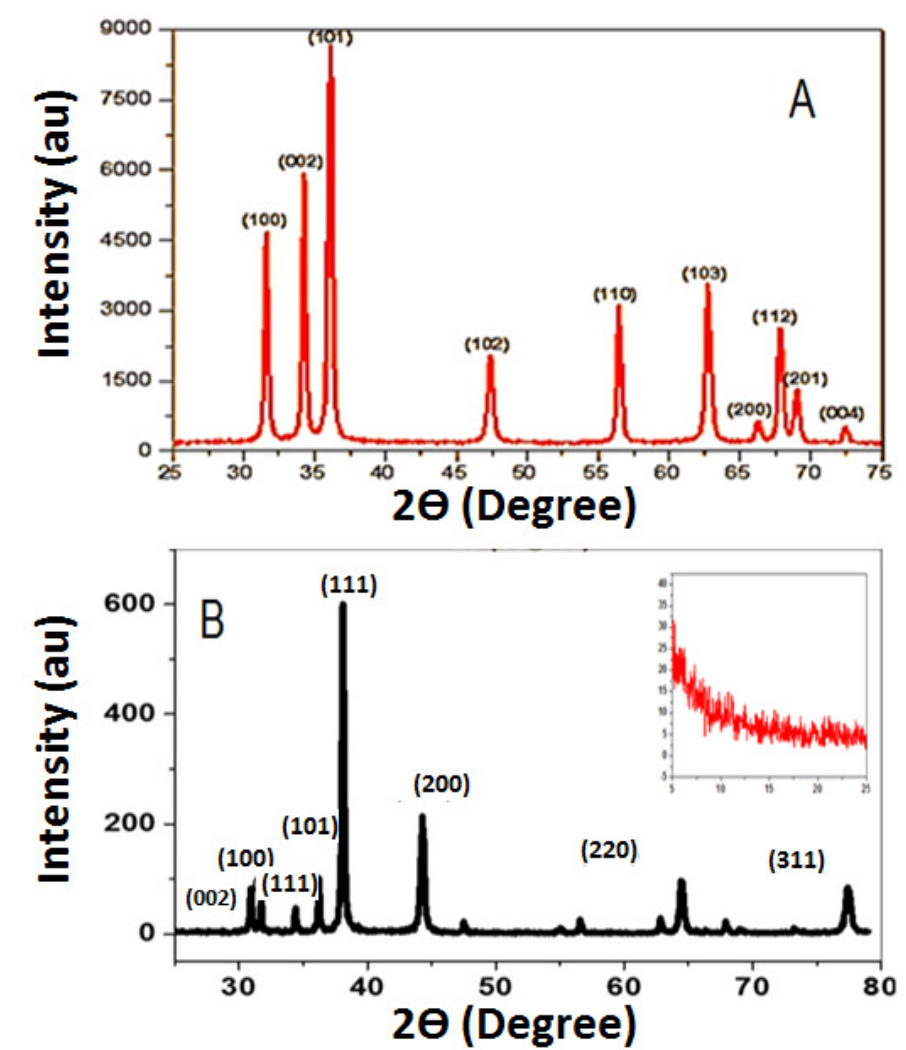
Figure 1. XRD patterns of ZnO NPs ( A ) and ZnO–Ag/PPy nanocomposite ( B ). Inset shows a broad peak of